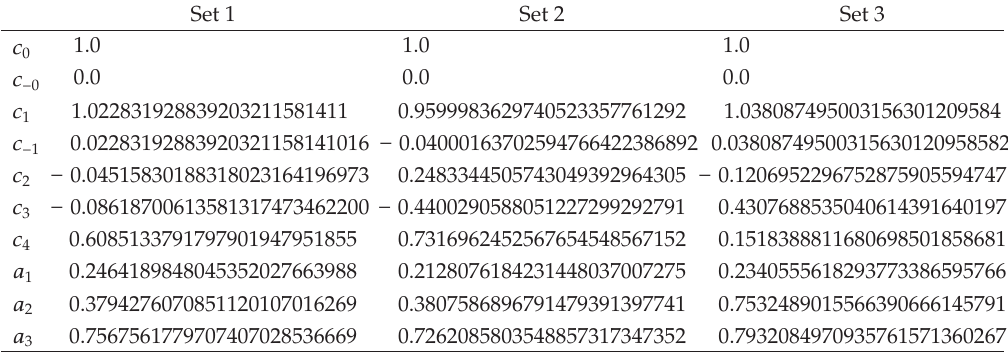
Table 3: Optimized ARK4-4 parameter